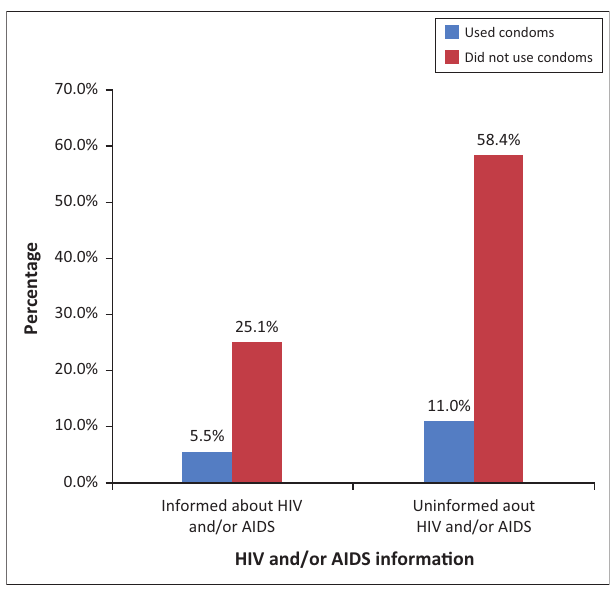
FIGURE 3: Relationship between information and condom use for prevention of HIV and/or AIDS.